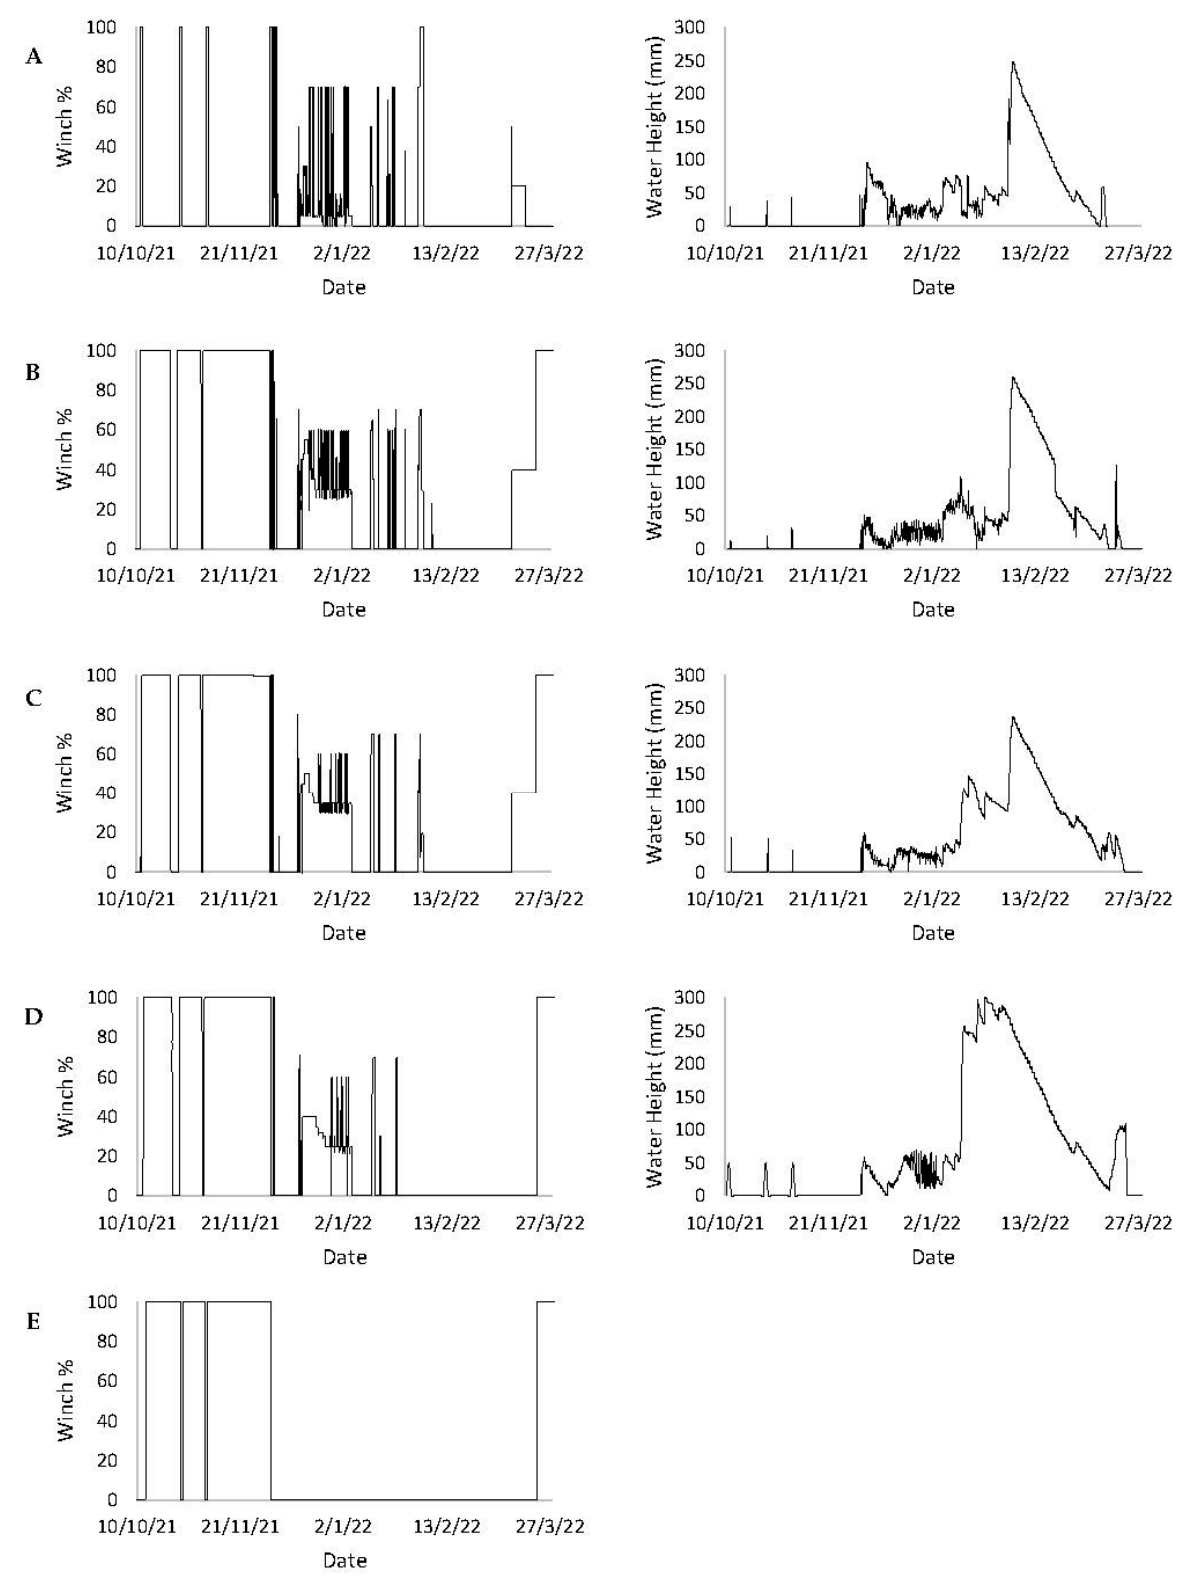
Figure 4. Seasonal outlet position (%) and water height (mm) for each bay at Site B. ( A – D ) Bay 1–4, respectively, and ( E ) drain.